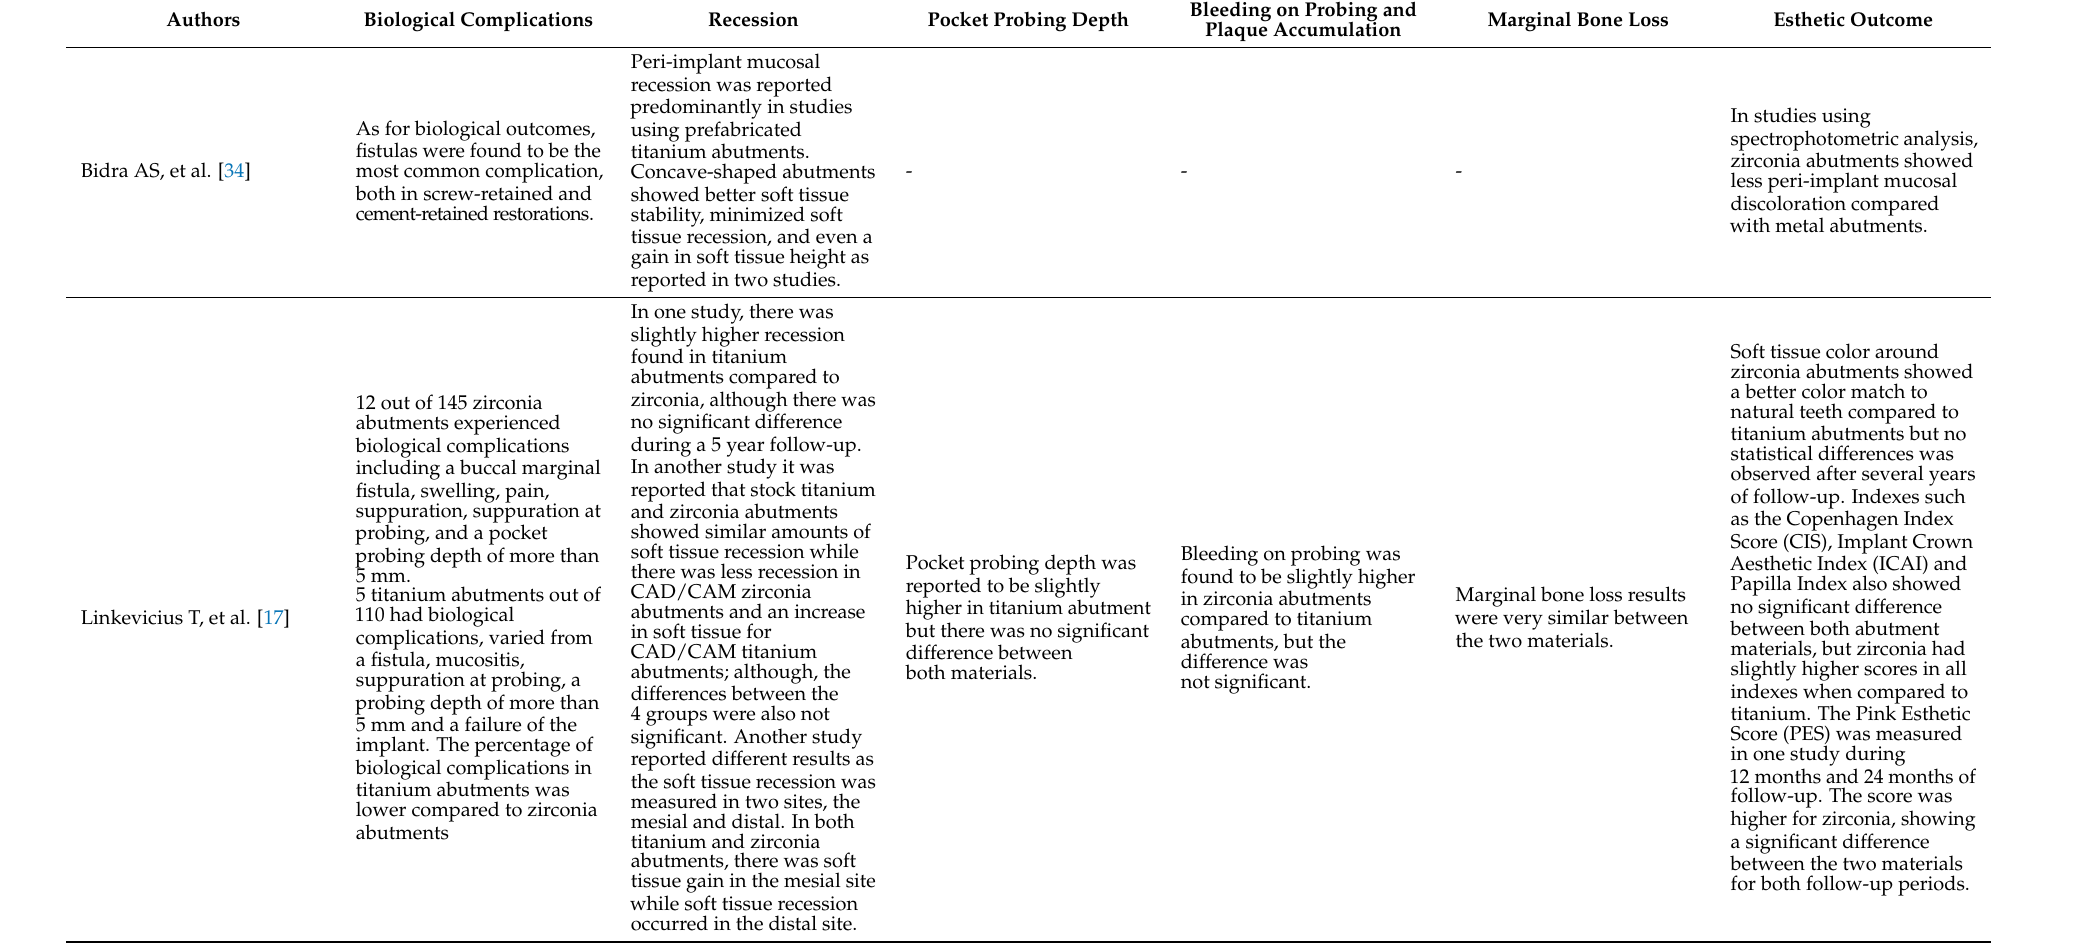
Table 5. Biological complications and esthetic result as reported in included systematic